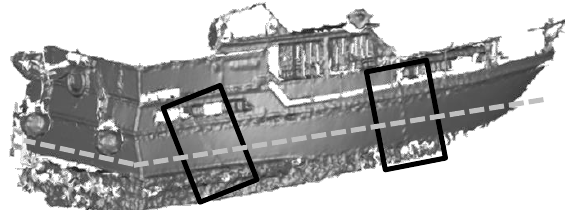
Figure 9: Uncorrected meshed point cloud of "Biene" Black rectangles highlight longish artefacts of the mesh that represent hoses in the figure above. These are used to inject air into the water in order to keep the immediate area around the ship free of ice. The dashed grey line represents an intersecting plane, whose outcome is depicted in Figure 10, in order to vividly illustrate the “deformation” which has been caused by the movement during the scan.